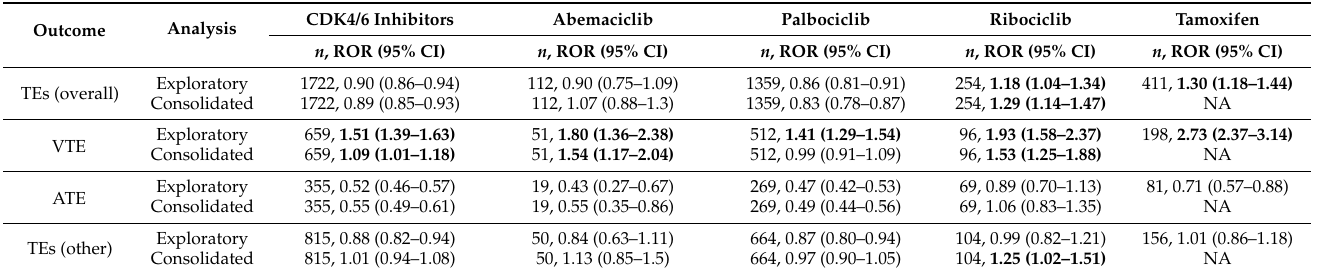
(Table 2). No significant disproportionality emerged for ATE, but ribociclib generated a disproportionality signal for “thromboembolic events (other)” (104; 1.25; 1.02–1.51). Table 2. Disproportionality analyses.